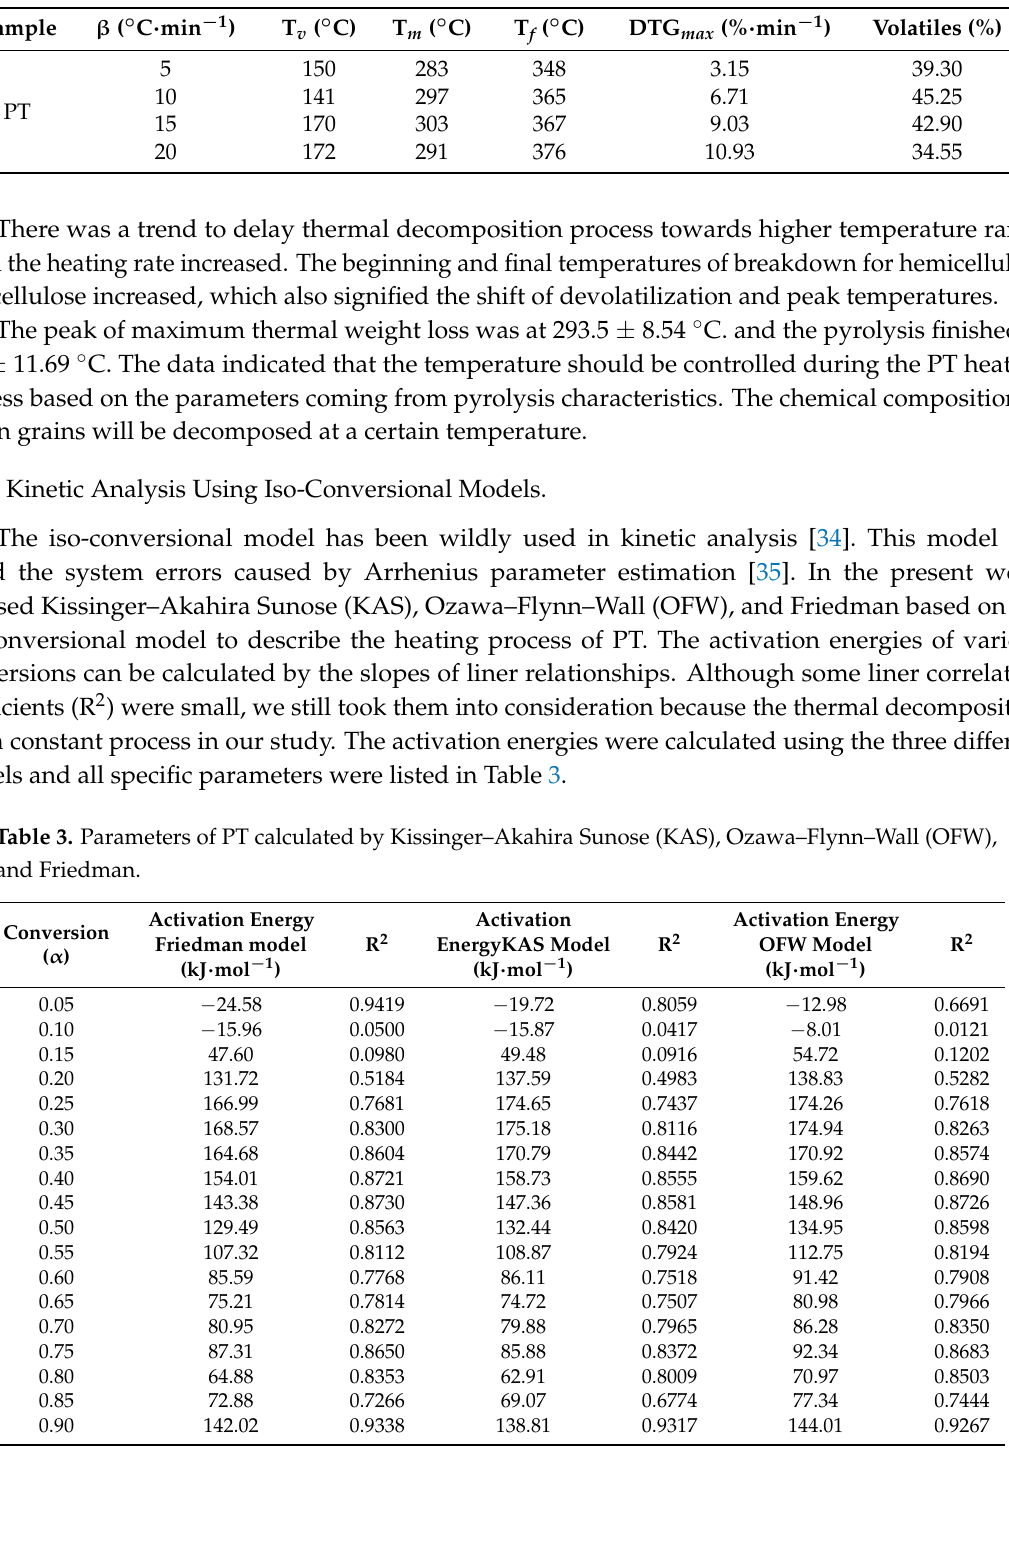
Table 2. Parameters of pyrolysis characteristics of PT.